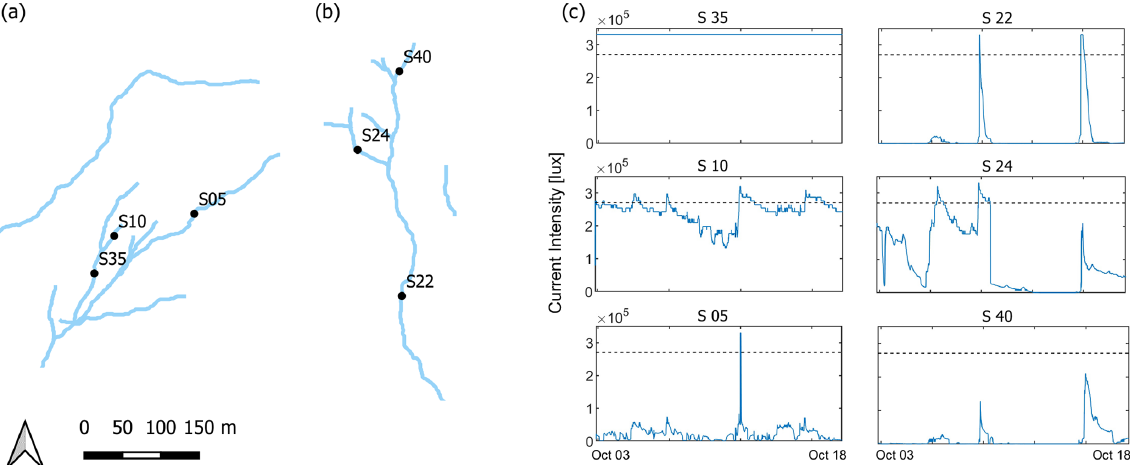
Figure 3. Examples of time series recorded by some of the sensors for 2 weeks between 3 and 18 October. Location of these sensors along the tributaries of Zone 1 (a) and 2 (b) . The dashed line represents the threshold of 270000 lux (c)